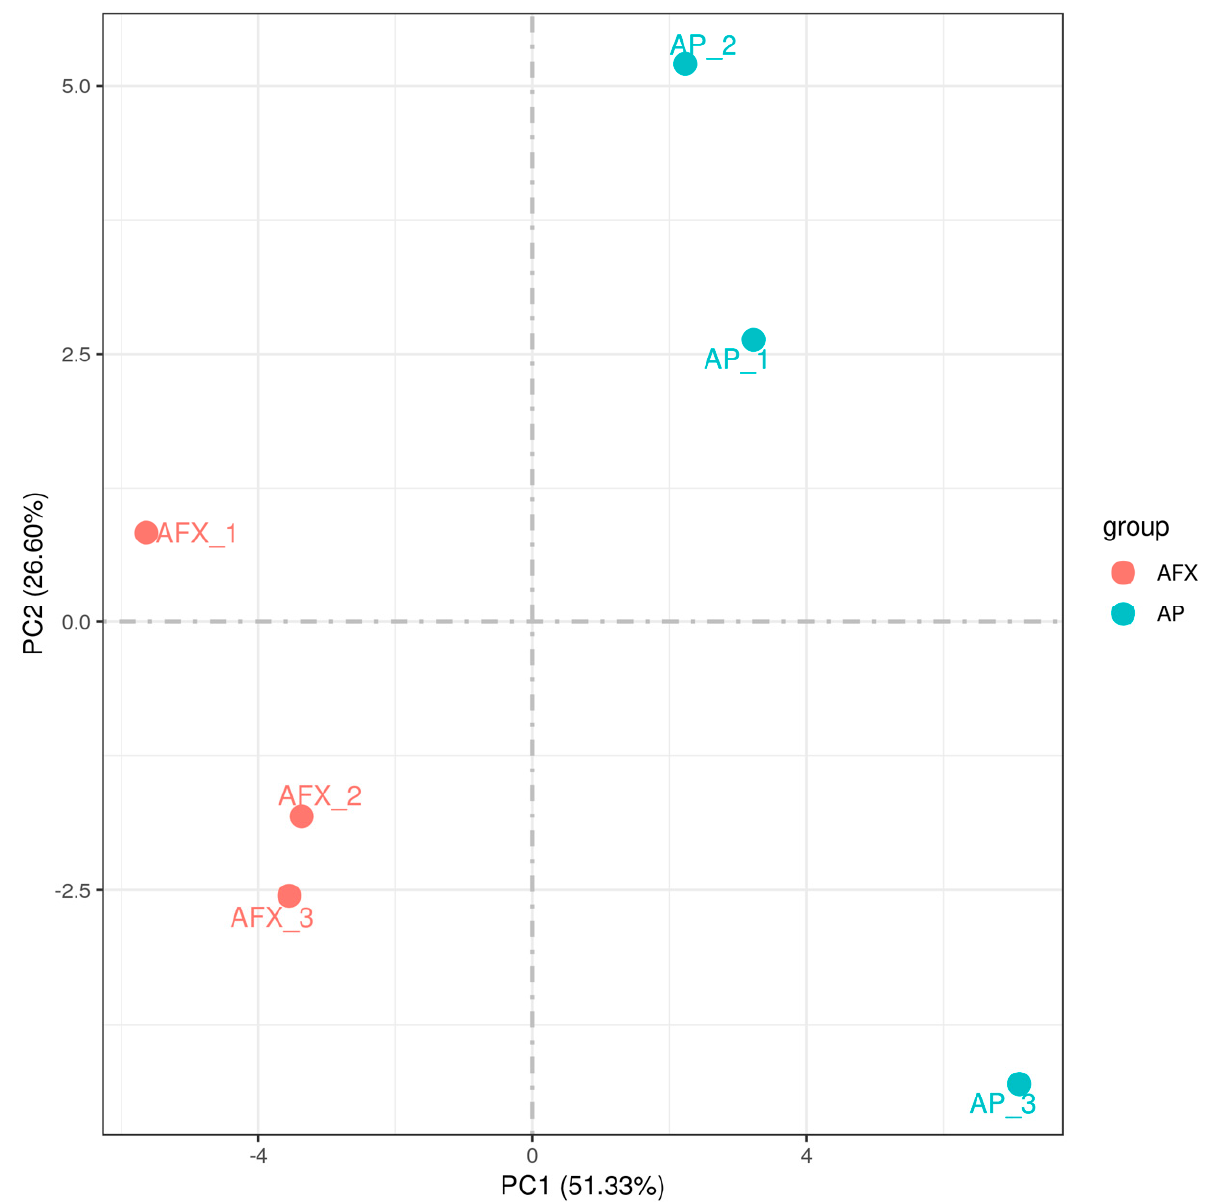
Figure 3. The PCA analysis of the transcriptomic profile derived from the autolysis and non-autolysis groups. AP, the cell expressing the antibacterial peptide (autolysis group); AFX, the cell expressing the aflatoxin-detoxifizyme (ADTZ) (non-autolysis group).